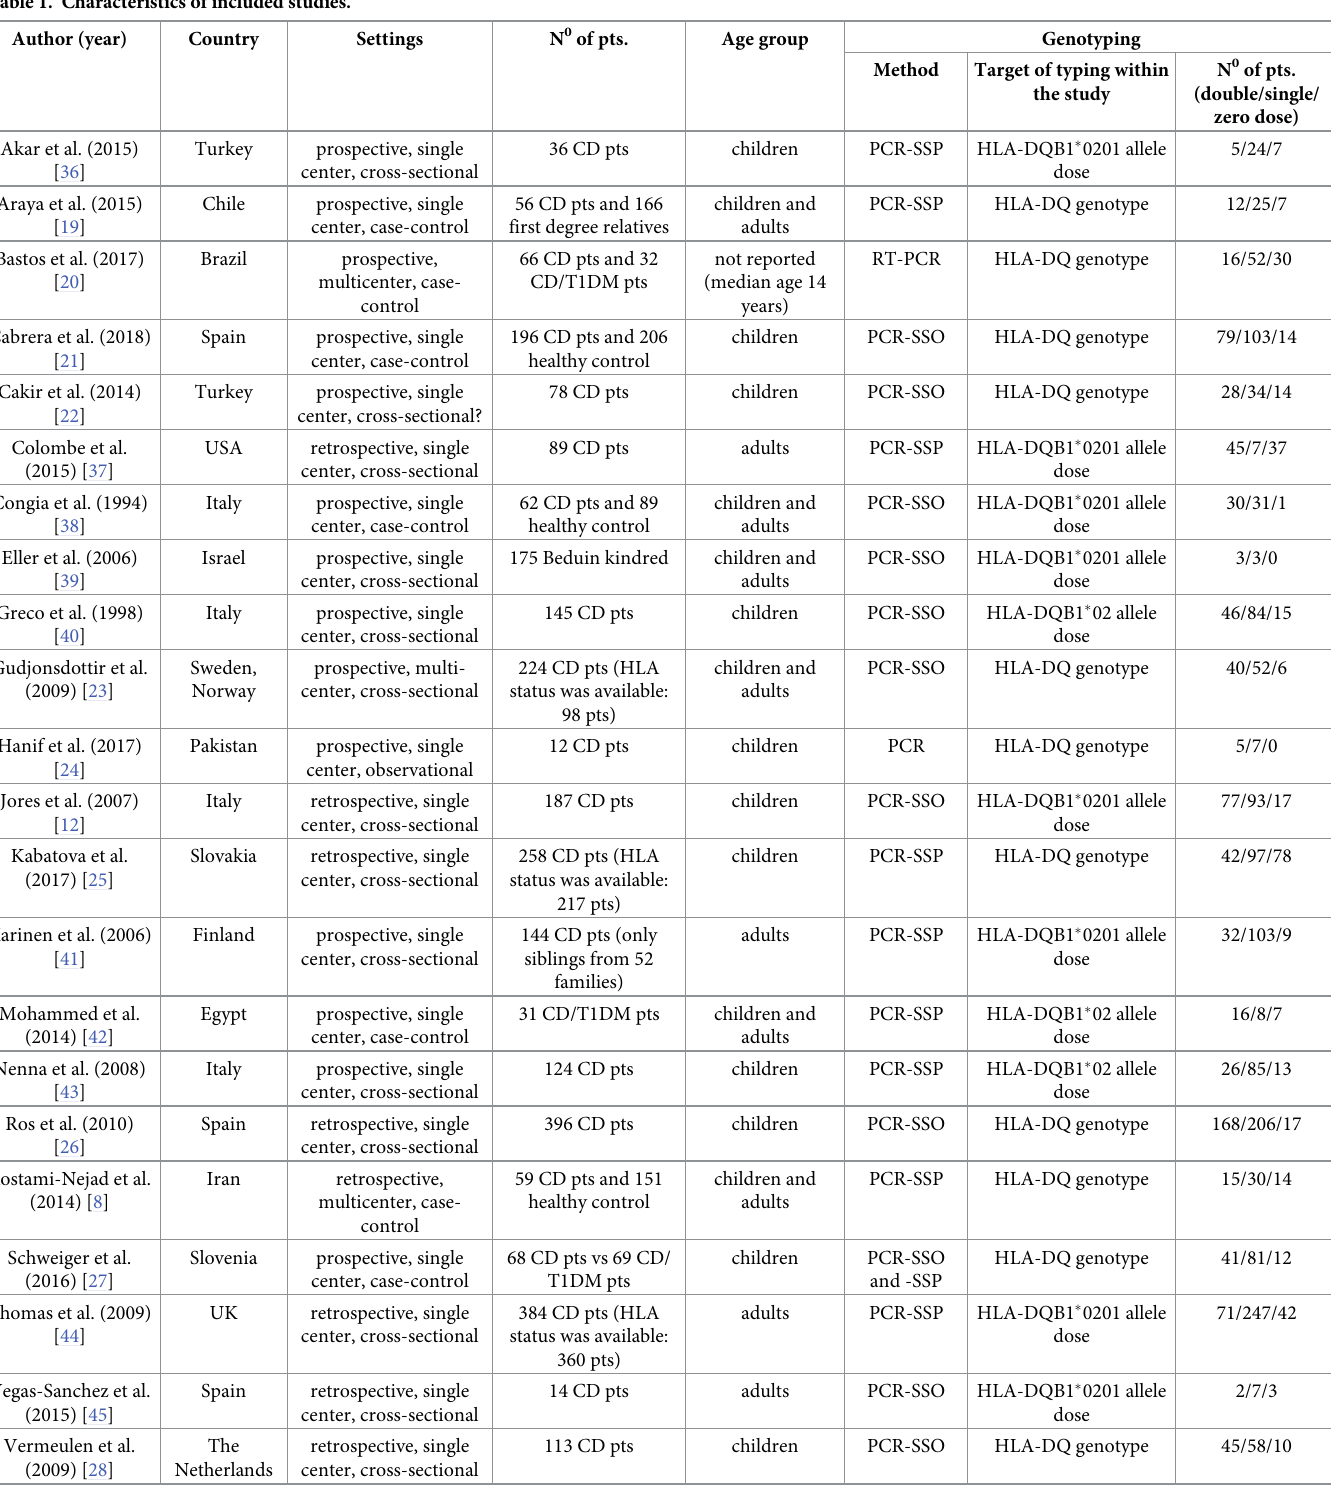
Table 1. Characteristics of included